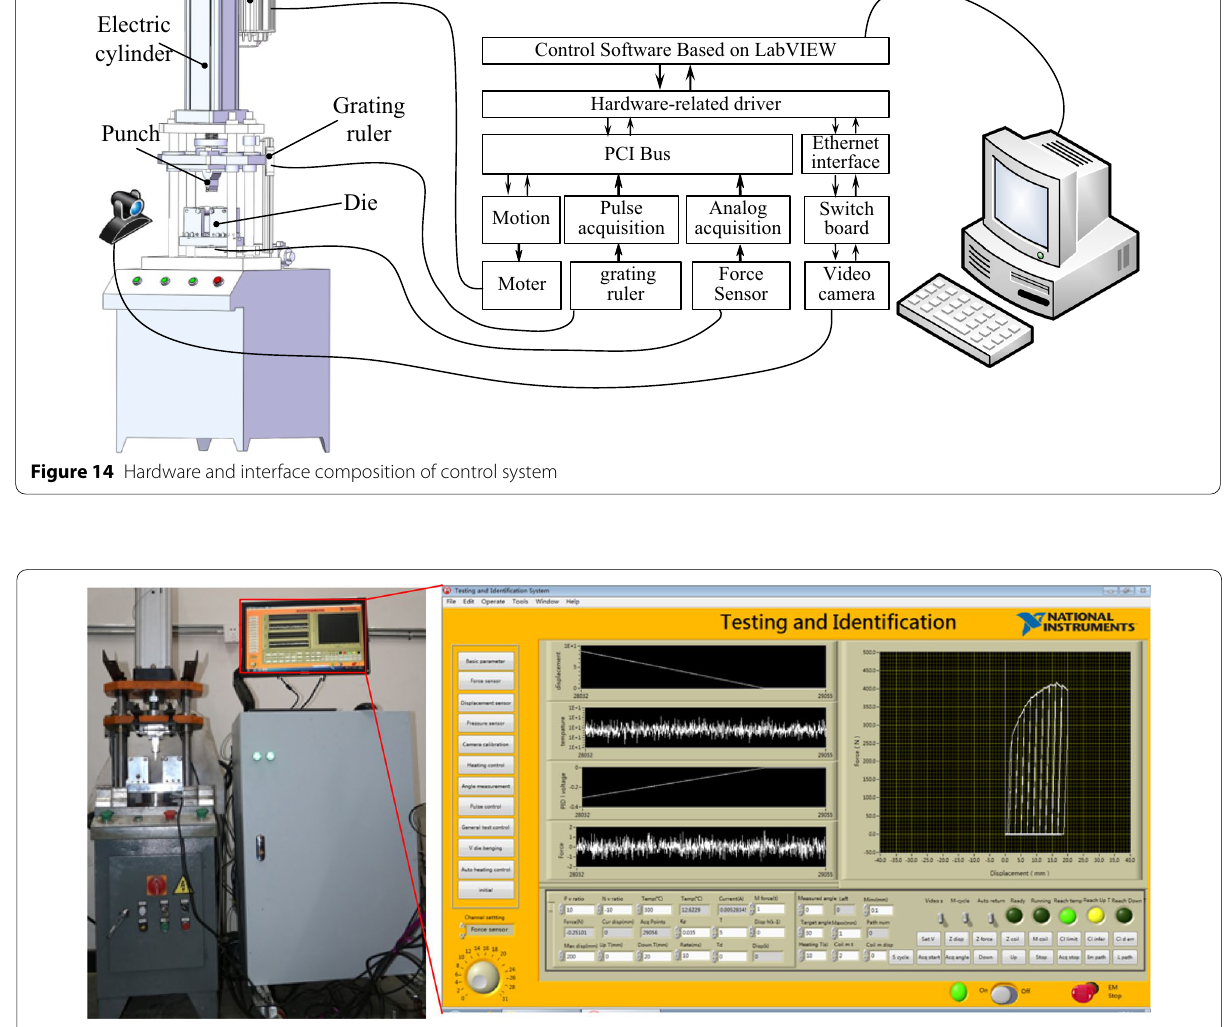
Figure 15 The mechanical system for air bending